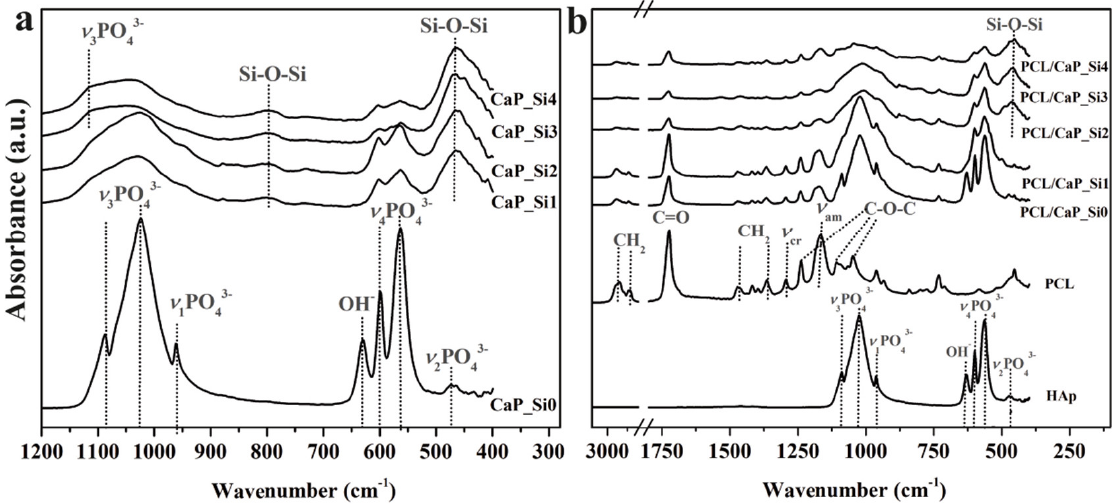
Figure 6. FTIR spectra of CaP_Si ( a ) and PCL/CaP_Si ( b ) scaffolds.